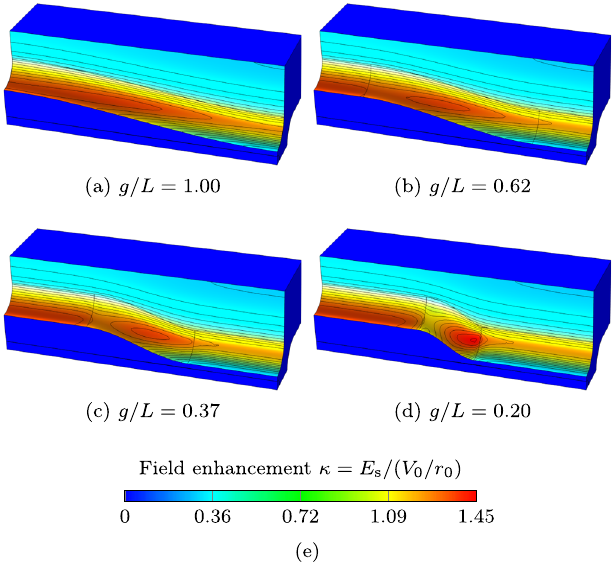
FIG. 9. Surface electric field in a trapezoidal cell, shown for varying gap lengths g=L (a) – (d), and (e)